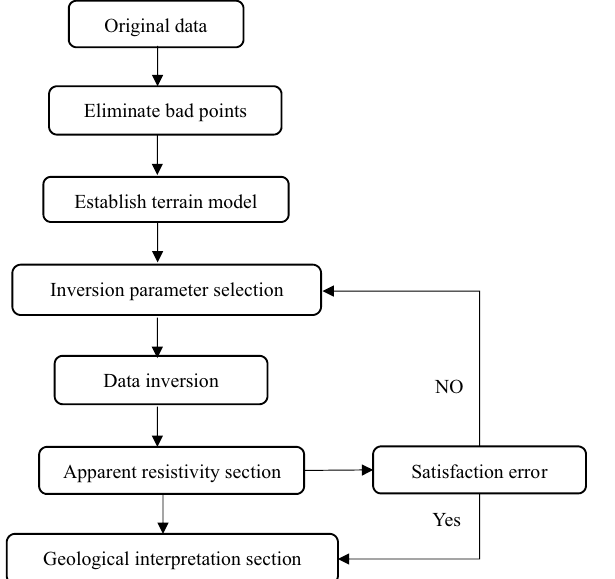
Figure 4. Flow chart of data processing.